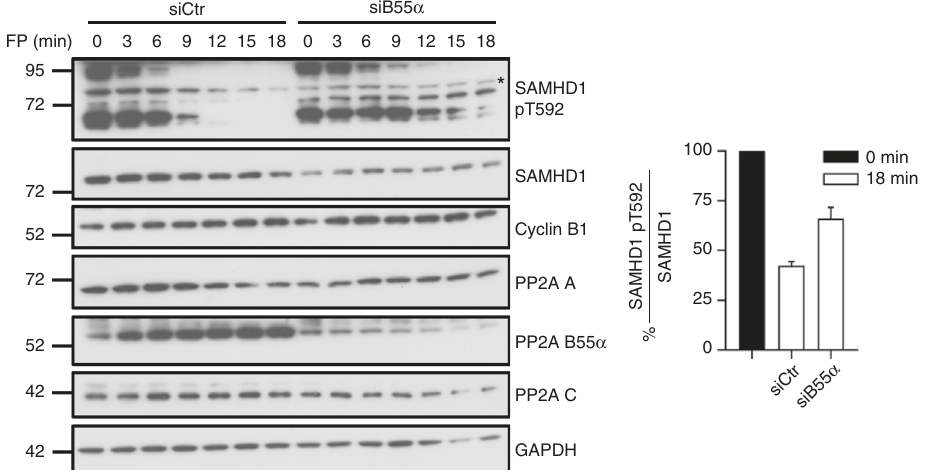
Fig. 6 SAMHD1 is dephosphorylated at T592 by PP2A-B55 α holoenzymes during mitotic exit in cycling cells. Knock-down of PP2A B55 α subunit leads to impaired and delayed dephosphorylation of SAMHD1 at T592 during mitotic exit. HeLa cells were either transfected with control siRNA or simultaneously with a single siRNA targeting PP2A B55 α subunit. Transfected cells were then arrested in mitosis using nocodazole and mitotic exit was induced chemically by adding fl avopiridol (FP) in the presence of MG-132. Cells were harvested at the indicated time points over a period of 18 min. Whole-cell lysates were analyzed by immunoblotting using antibodies speci fi c to the indicated proteins. For quanti fi cation, the signal of phosphorylated SAMHD1 ( = SAMHD1 pT592; signal marked with asterisks, compared to SAMHD1 pT592 signal in non-synchronized cells (see Supplementary Fig. 5f)) was normalized to total SAMHD1 and level of SAMHD1 pT592 within 18 min compared between siCtr- and siB55 α -transfected cells. Immunoblot data shown are representative of two independent experiments, while the quanti fi cation graphs represent the mean ± SD of both